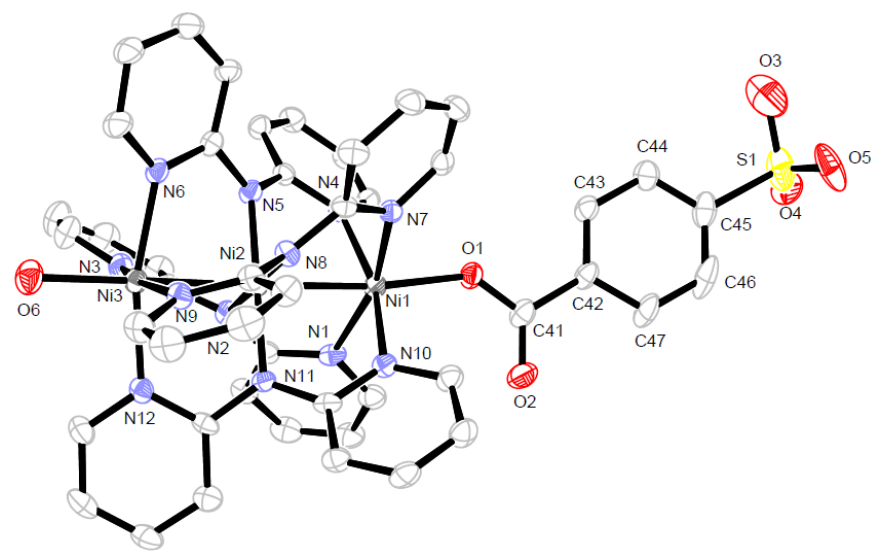
Figure 1. View of molecular structure of 1 . H atoms and lattice water molecules are omitted for